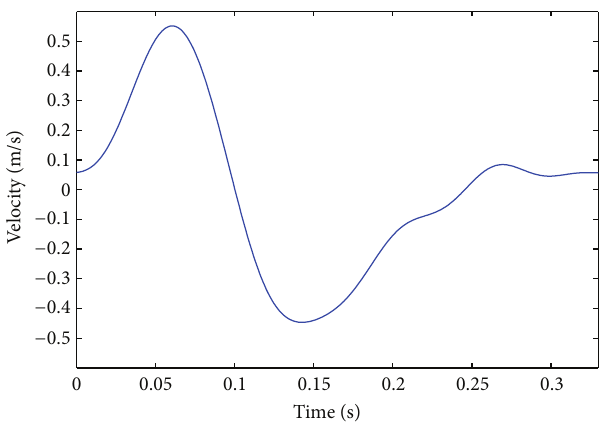
Figure 2: Velocity waveform used as inlet boundary condition for all